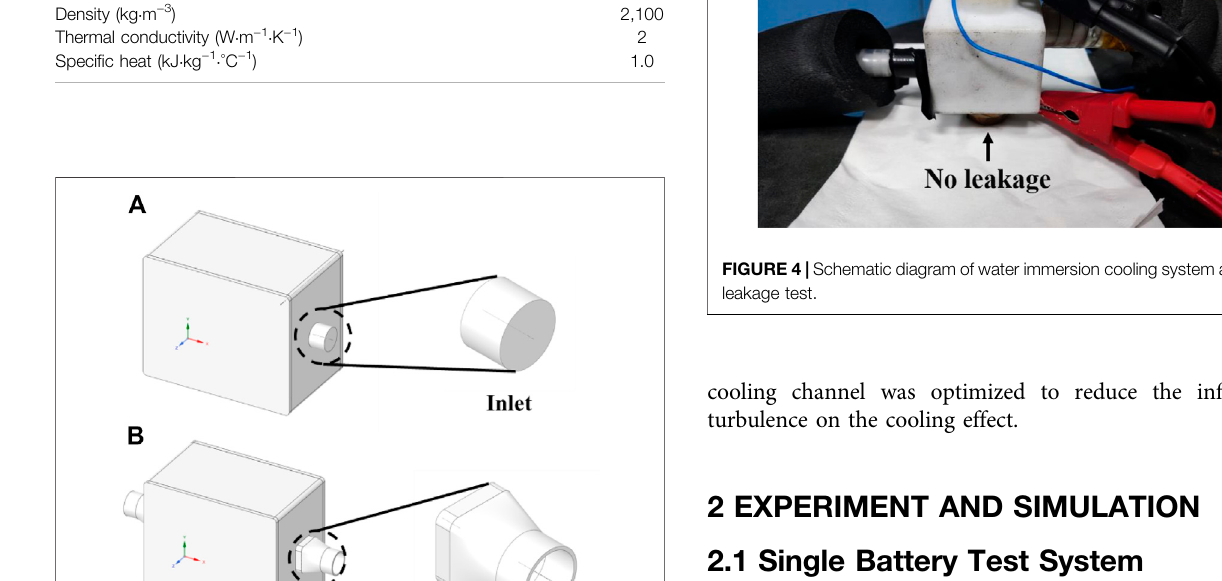
TABLE 1 | Thermal physical properties of battery. Property